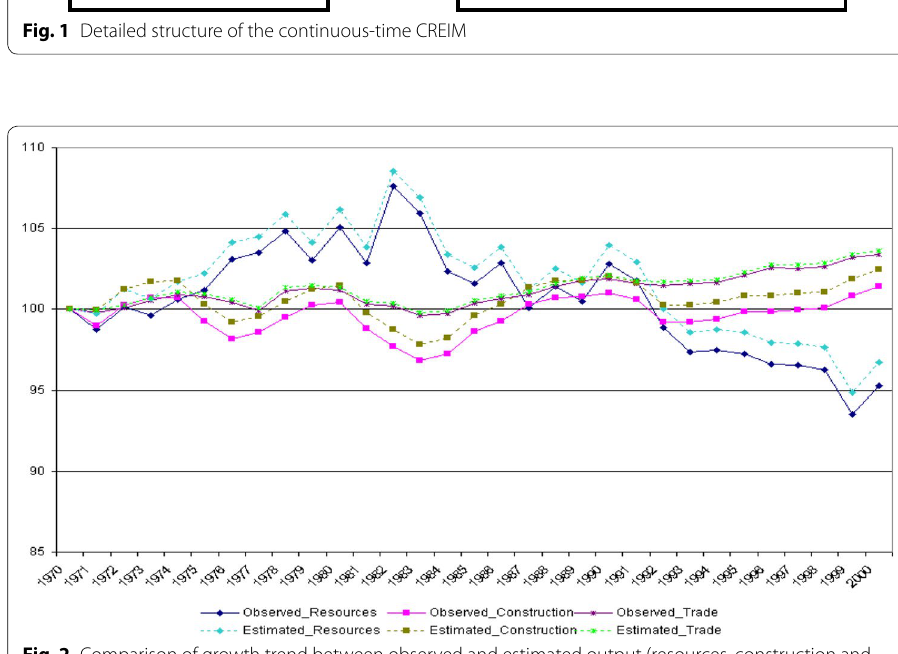
Fig. 2 Comparison of growth trend between observed and estimated output (resources, construction and trade sector, 1970 =